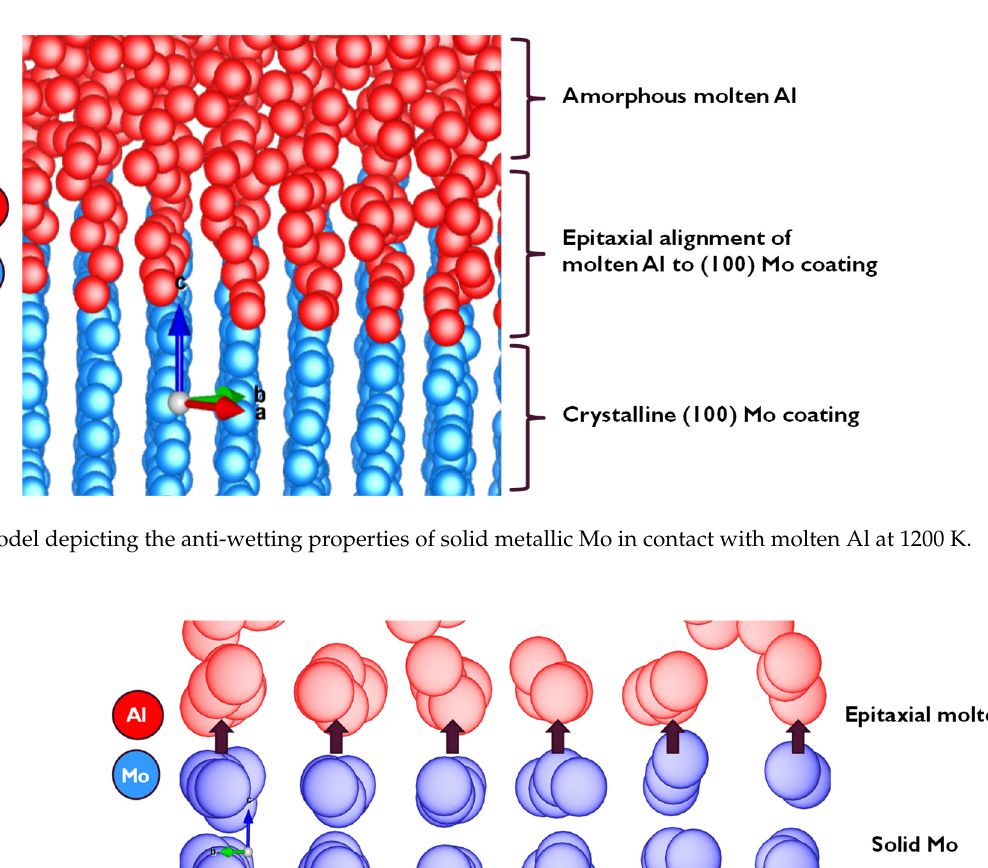
Figure 8. The epitaxial alignment of molten Al to Mo (100) plane.